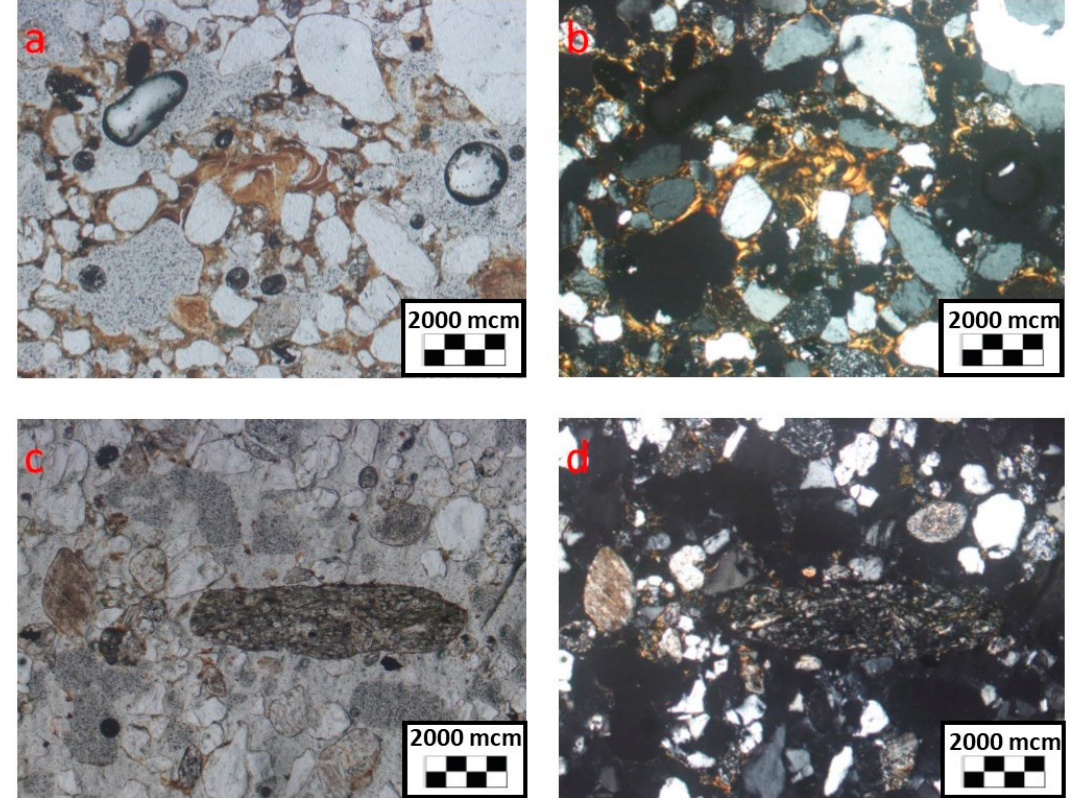
Figure 7. Micromorphological features of the upper and bottom parts of Bwb horizon (Paleosol 2): ( a , b ) Light brown, speckled fine mass, equal to single spaced fine enaulic (partly chitonic) related distribution in upper part of Bwb (PPL (plane polarized light) and XPL (crossed polars), respectively); ( c , d ) almost absence of clay and coarse fragments of rocks in the bottom part of Bwb horizon (PPL and XPL, respectively).